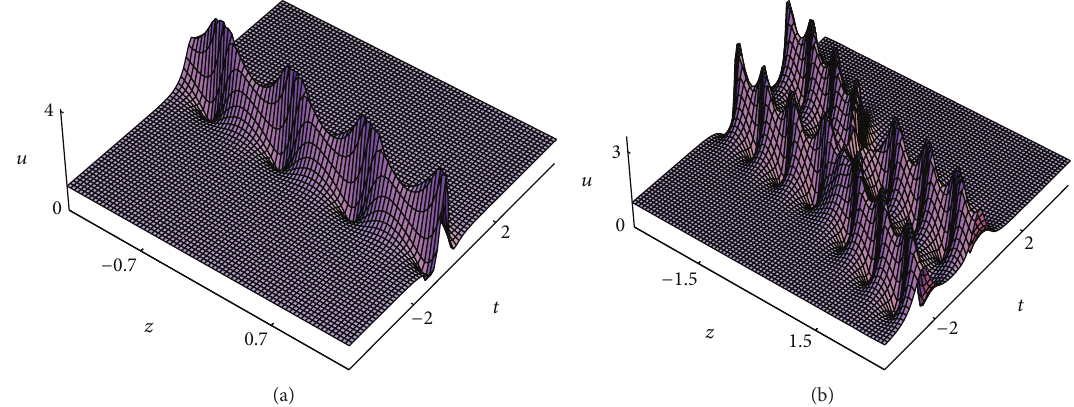
Figure 2: Evolution of the breather solutions of (1). Parameters are (a) 𝑢 𝑐 = 1 , 𝜅 = 0 , 𝛿 = 3 , 𝜆 1 = 2.05 + 2.05𝑖 , Γ = 0 and (b) 𝑢 𝑐 = 1 , 𝜅 = 0 , = 2.05 + 2.05𝑖 , 𝜆 = 2 + 2𝑖 , 𝛿 = 3 , Γ = 0 . 𝜆 1 2